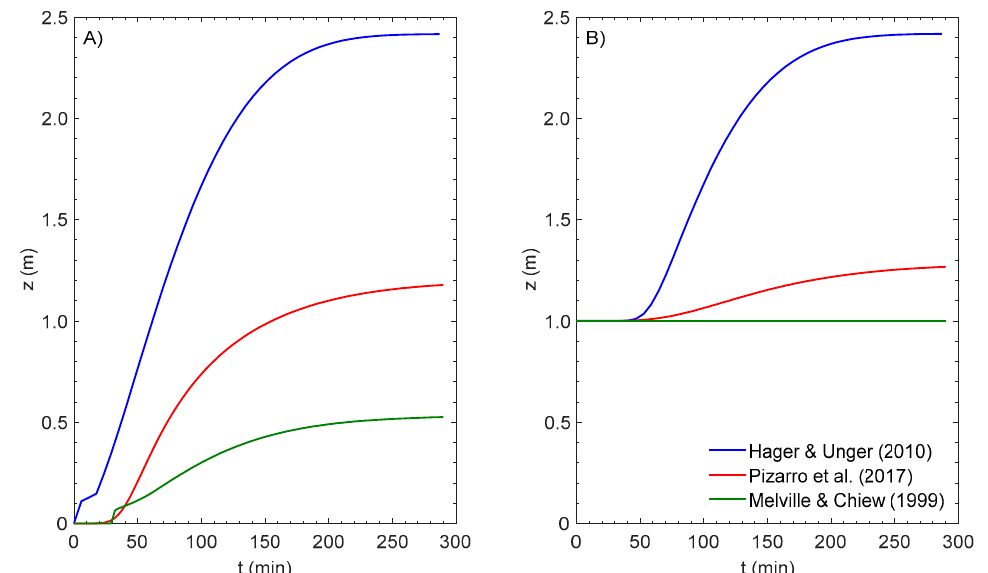
Figure 5. Temporal evolution of the scour depth under a single flood scenario corresponding to Q p = 8.7 (m 3 /s), k = 2, t p = 147 (min), and total flood duration of 294 (min). ( a) Initial scour depth z = 0 (m). ( b) Initial scour depth z = 1.0 (m).